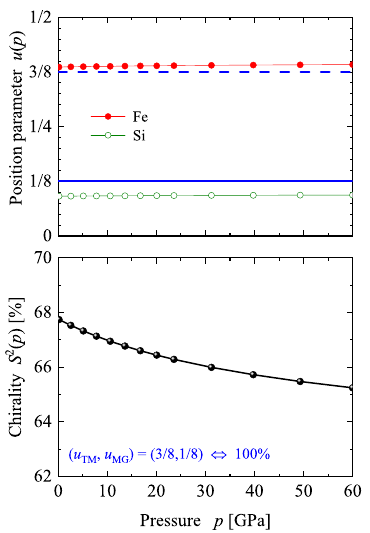
Figure 16. Pressure dependence of the chirality of FeSi. The position parameters (symbols connected by lines) for Fe and Si and the continuous chirality measure S 2 ( p ) are shown. The position parameters resulting in S 2 = 1 are marked in the upper part by full (1/8) and dashed (3/8) lines